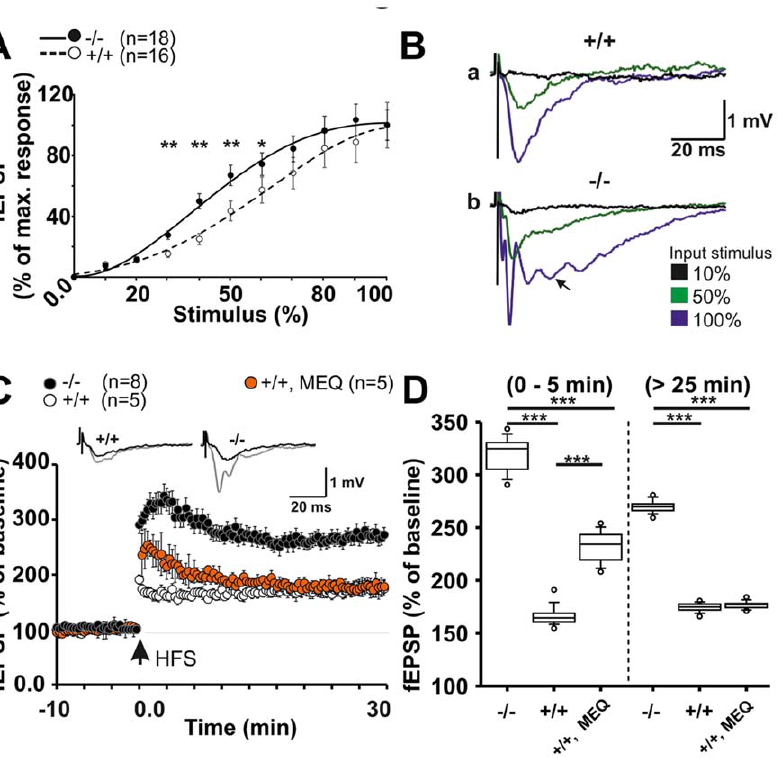
Figure 2. Loss of Panx1 alters postsynaptic responses in the hippocampal CA1 area. a, IO-relations demonstrate increased excitability of acute Panx1 2 / 2 hippocampal slices ( 2 / 2 , solid line; + / + , dashed line). b, fEPSP sample traces at 10, 50, 100% of the maximum input stimulus intensity. At high input stimuli, a characteristic oscillatory component appears in Panx1 2 / 2 but not Panx1 + / + mice. c, Panx1 2 / 2 animals show increased LTP responses during the early (0–5 min) and persistent phase (25–30 min). Insets in (C) depict sample traces before (black) and 30 min post (grey) high frequency stimulation (HFS). Note that inhibition of Panx1 by 50 nM mefloquine (MEQ) does not fully emulate the knock out effect. c, Comparing fEPSP amplitudes reveals significant increased early and persistent LTP in Panx1 2 / 2 slices. MEQ does not reconstitute the Panx1 + / + response to Panx1 2 / 2 levels. Statistics: (a) two tailed Mann-Whitney test (non-parametric), (c) ANOVA (early: F3,64 =573.7; P , 0.0001; late: F3,64 =259.1; P , 0.0001) and Holm-Sidack post-hoc test.